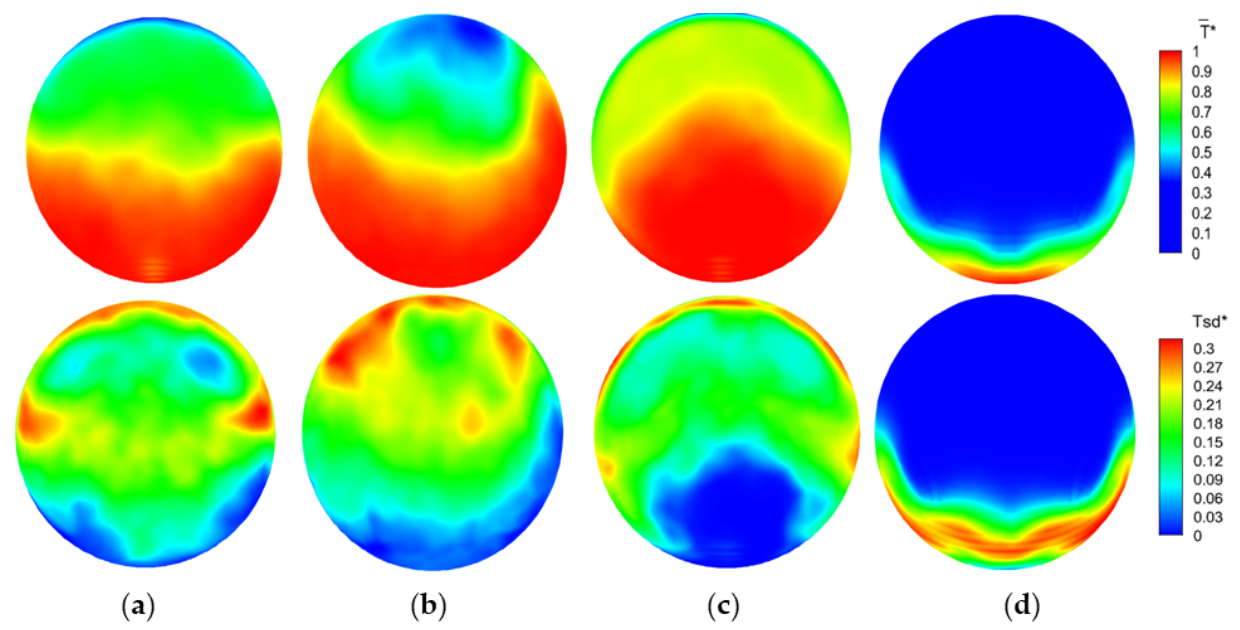
Figure 14. Temperature distribution upstream (the upper figures show temperature T * distribution and the lower figures show temperature T sd* distribution): ( a ) A cross-section at Z = − 0.2 D m in case1; ( b ) a cross-section at Z = − 0.5 D m in case1; ( c ) a cross-section at Z = − 0.18 D m in case7; ( d ) a cross-section at Z = − 1.55 D b in case12.